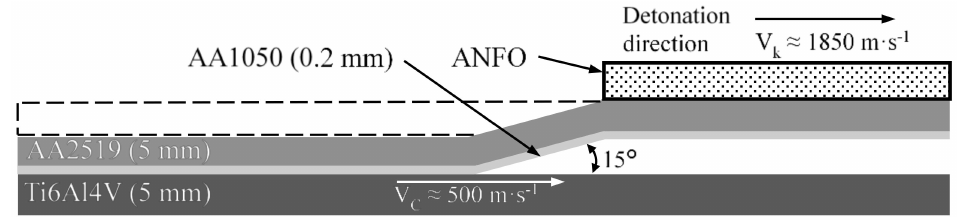
Figure 1. Schematic presentation of the process of AA2519–AA1050–Ti6Al4V composite creation.